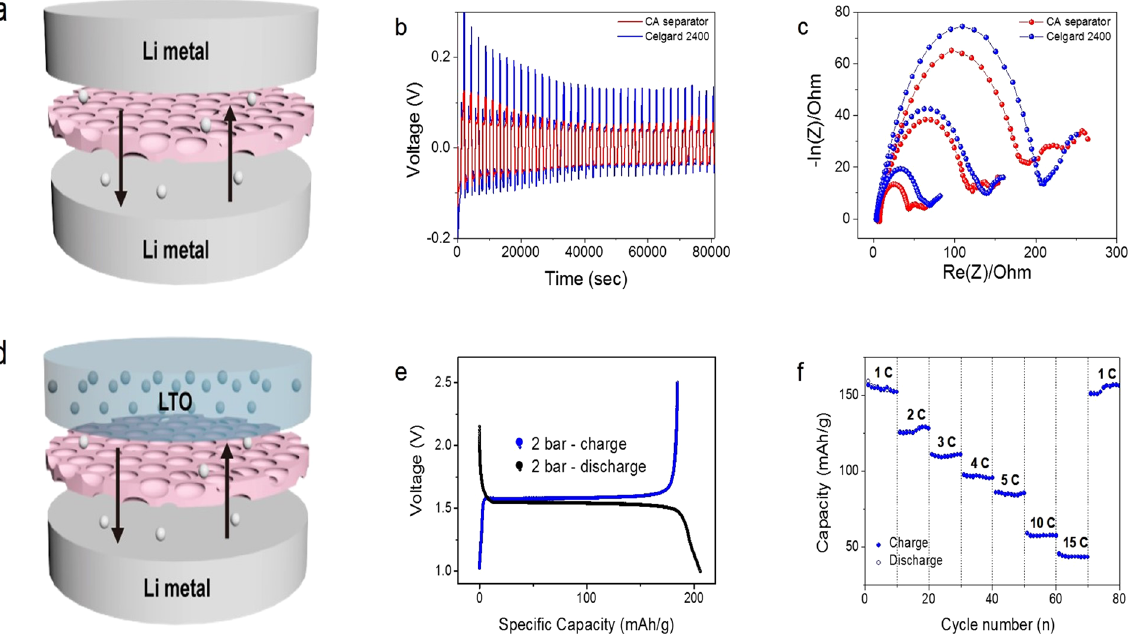
Figure 9. ( a ) Schematic representation of the Li metal/cellulose acetate (CA) separator/ Li metal symmetry cell architecture. ( b ) chronopotentiometry results of symmetry cell with the polymeric Celgard separator (blue line) and the 1:0.23 CA/Ni(NO 3 ) 2 polymer separator at a water pressure of 2 bar (red line). ( c ) The Nyquist plots of symmetry cells with Celgard (blue dots) and CA (red dots) separators as a function of cycle number ( d ) Schematic representation of the Li metal/CA separator/LTO half-cell architecture. ( e ) Galvanostatic discharge- charge profiles of half-cell with the 1:0.23 CA/Ni(NO 3 ) 2 polymer separator at a water pressure of 2 bar. ( f ) Rate performance of Li metal/CA separator/LTO